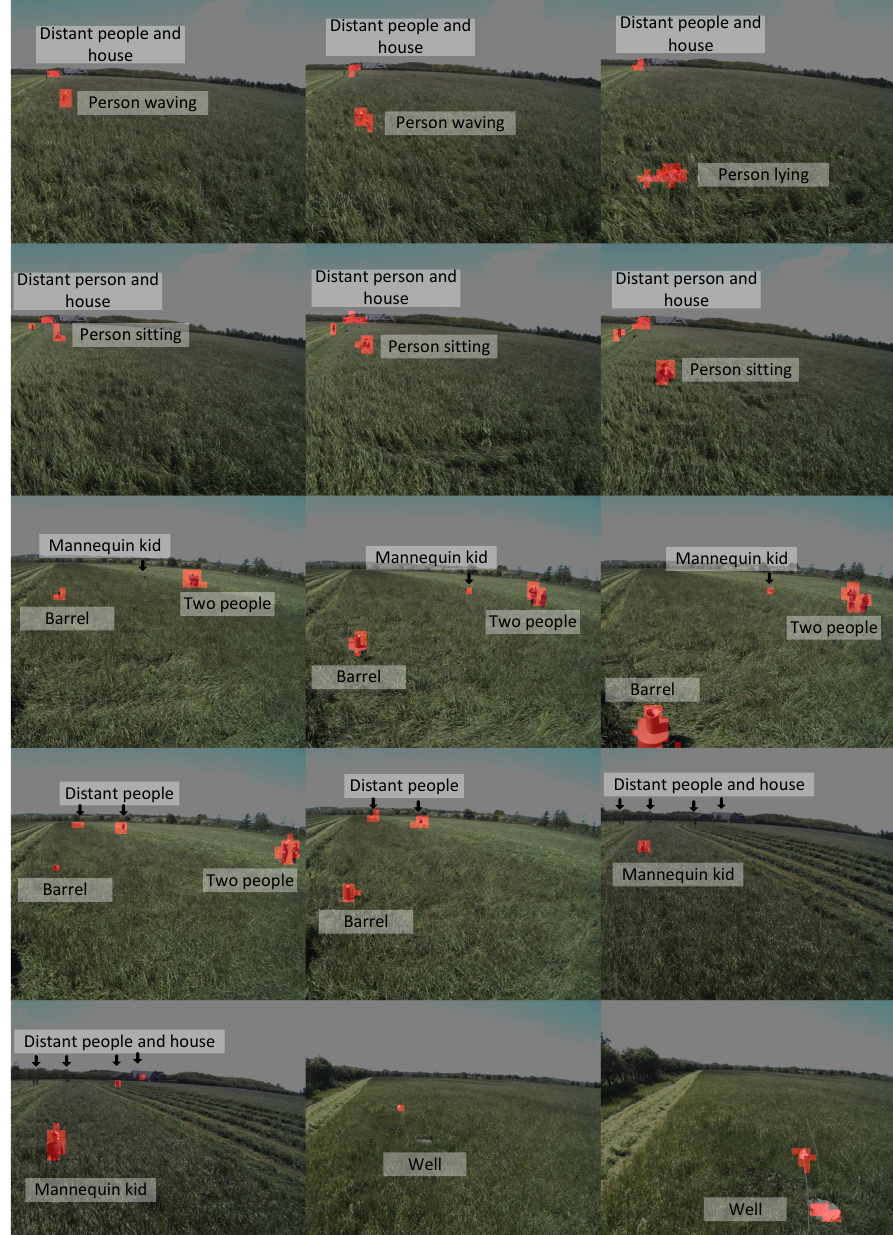
Figure 15. DeepAnomaly detections. No false positives are present in the